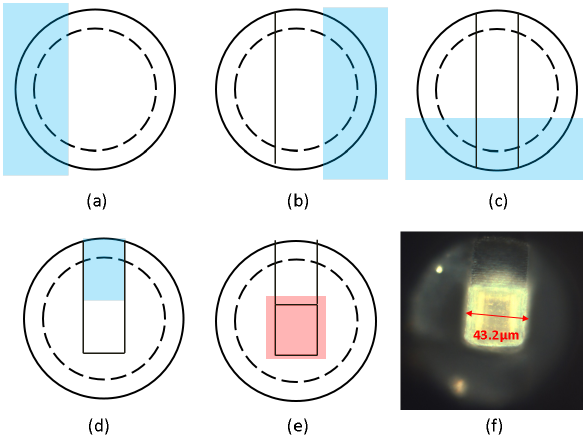
Figure 3: Micromachining procedures for micro-cantilever beam structure (a)–(e) and an optical microscope picture of the end face of a fabricated sensor (f)